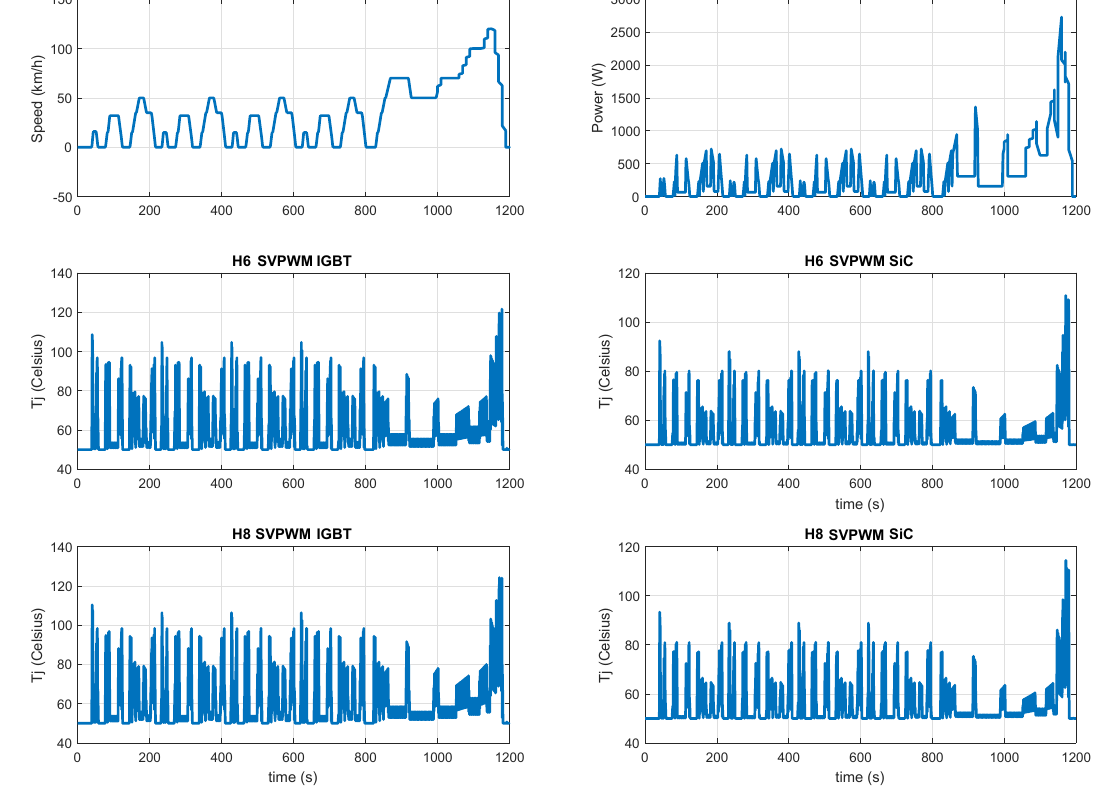
Figure 17. Junction temperature evaluation with silicon IGBTs and SiC power MOSFETs according to the New European Driving